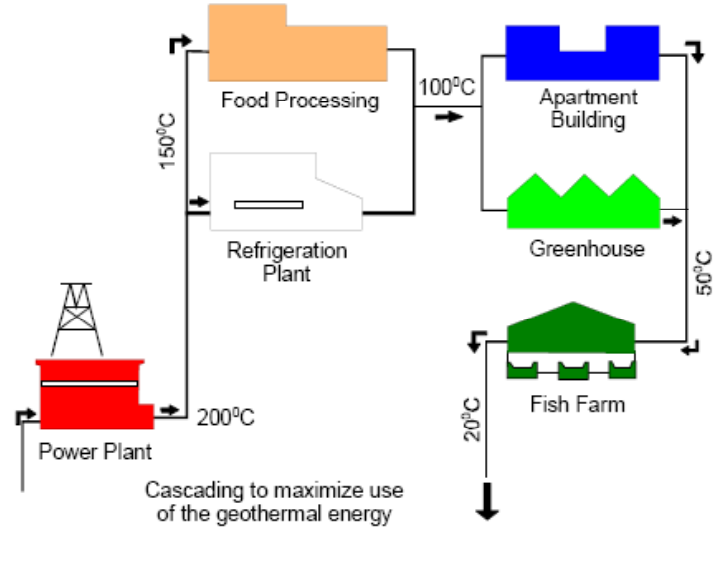
Figure 11. An example of geothermal cascading (combined heat and